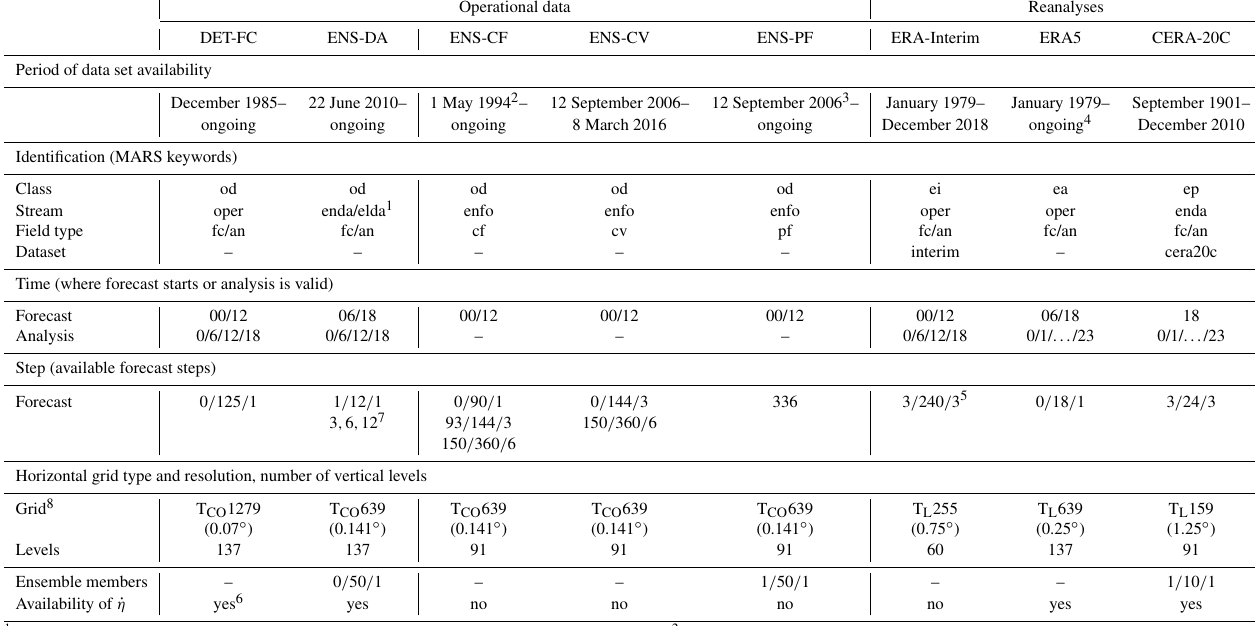
Table 1. Overview of ECWMF data sets with associated parameters required in MARS requests (Berrisford et al., 2011; Laloyaux et al., 2016; ECMWF, 2019e,h). DET-FC stands for “Deterministic forecast”, ENS-DA for “Ensemble data assimilation”, ENS-CF for “Ensemble control forecast”, ENS-CV for “Ensemble validation forecast” and ENS-PF for “Ensemble perturbed forecast”. All times are in UTC, all steps in hours. Dates are written as DD/MM/YYYY (day optional). Steps and members are written in the format of Start/End/Step. The specifications for the operational data sets are valid for current data at the time of publication (except ENS-CV – deprecated since 8 August 2016). For details about resolution and other parameters which have changed in the course of time, see Tables 2 and 3. The grid type for the operational data (T CO xxx) refers to the spectral cubic octahedral grid and for the reanalysis data (T L xxx) refers to linear spherical harmonics. The identification parameter “Dataset” is to be used by public users only. Note that there is also the ERA40 reanalysis; however, as it has been superseded by ERA-Interim and ERA5 and thus rarely used nowadays, it is not included here (but flex_extract should still be